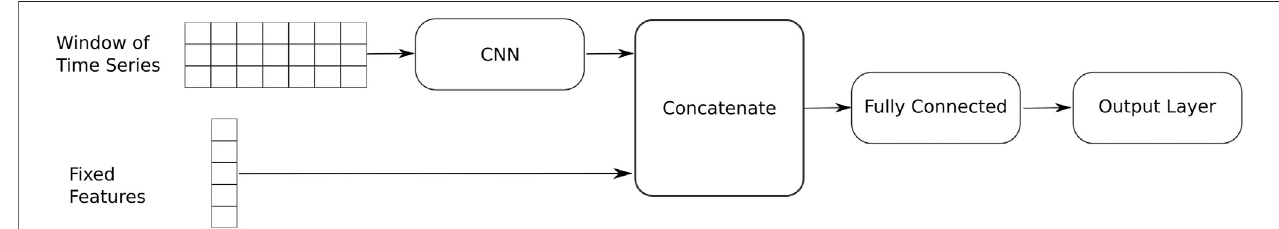
FIGURE 3 | Network schematic for sliding window model. We pass fi lters across the residual time-series to engineer features from each time-series, then concatenate these with the time invariant featuresto create afeaturevector, which is passed through aseriesof fully connected layers, and some outputlayer isapplied to the result. The example shown is for a single traf fi c incident being passed through the network. The number of boxes for features is not to scale. The window of time- series represents three variables and a window size of seven in this simple